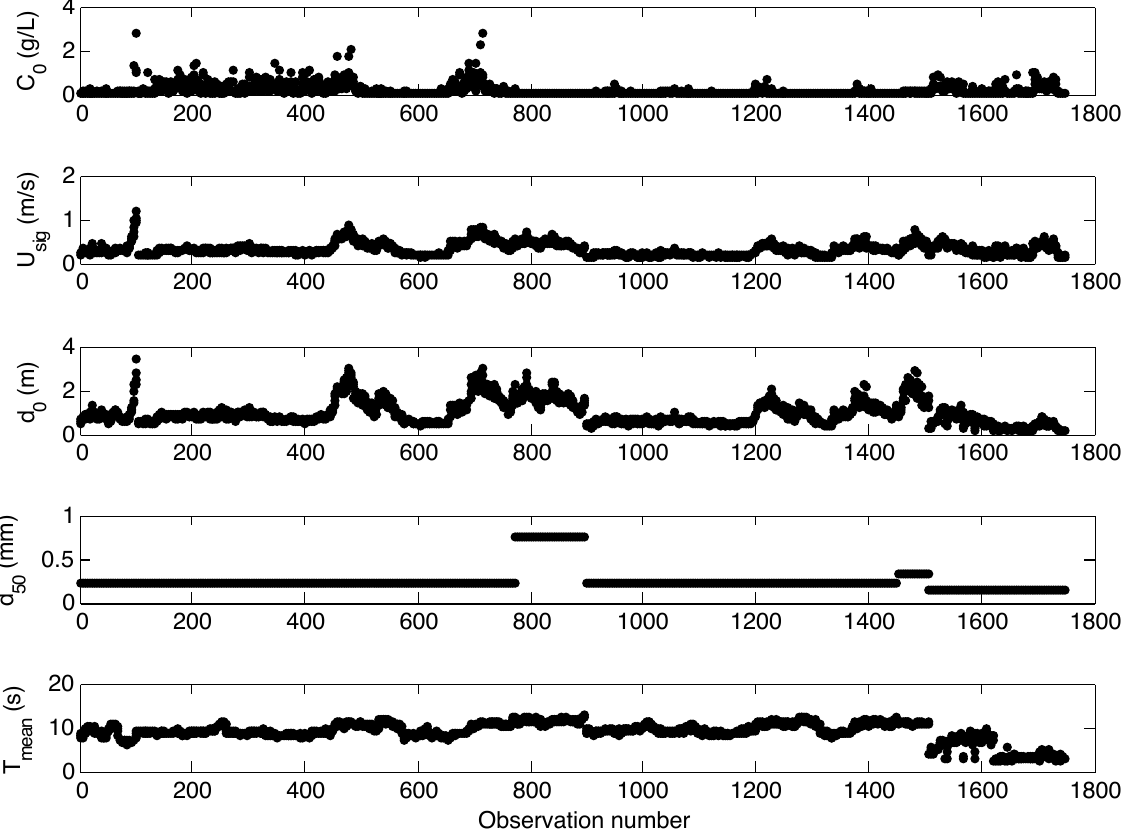
Figure 2. Observations of suspended sediment reference concentration data set C 0 and concomitant measurements of significant wave velocity at the bed ( U sig ), wave orbital excursion at the bed ( d 0 ), mean grain size of bed material ( d 50 ), and mean spectral wave period at the bed ( T mean ). Note that mean grain size of bed material is shown here in millimeters. A similar figure appears in Oehler et al.